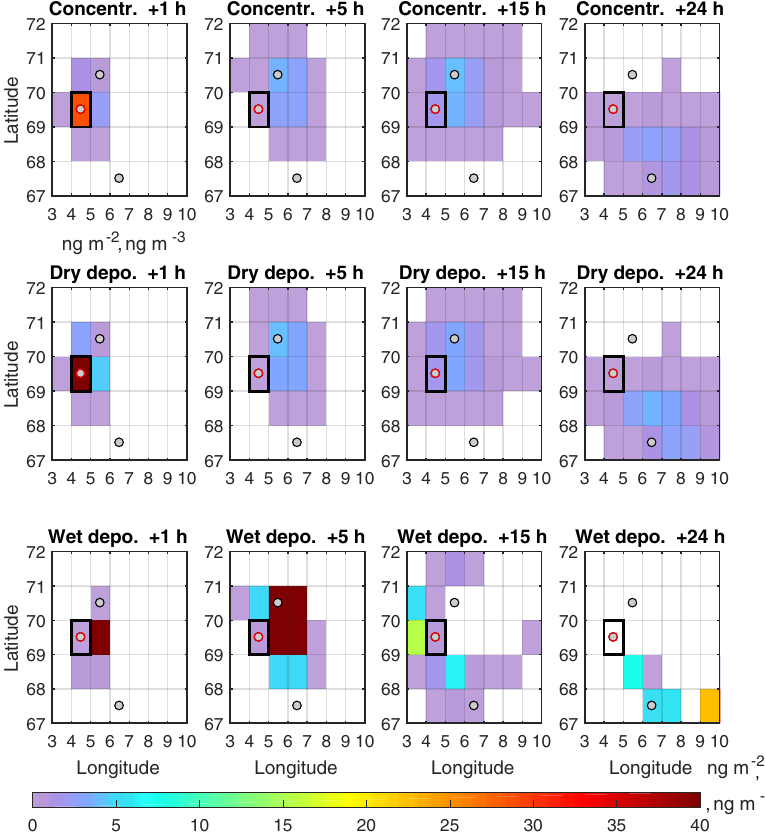
Figure 2. Concentration of BC (ngm − 3 ) in the lowest 100m of the atmosphere (top panels), dry deposition (middle panels) and wet depo- sition (bottom panels) (both in ngm − 2 ) resulting from a 10kg BC emission in the grid cell marked with a black rectangle. Grid cells are shown with black horizontal and vertical lines. The panels show (from left to right) the results 0–1, 4–5, 14–15 and 23–24h after the start of the emission. The shaded grey circles mark grid cells for which the forward model output (as shown here) was compared with backward model simulations, i.e. where particles were released in backward